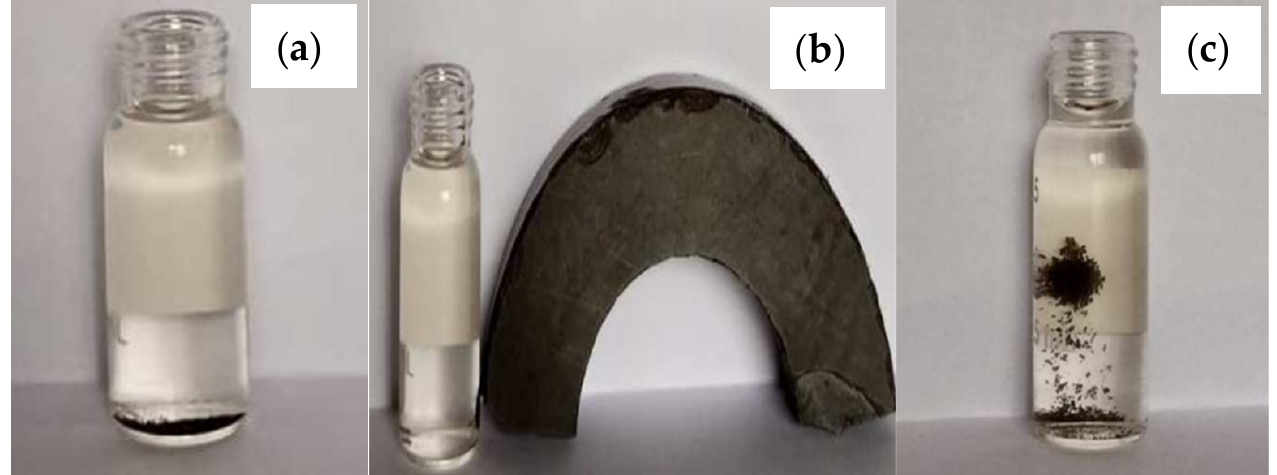
Figure 2. ( a ) nCDp/DT-Fe@MM without external magnetic field, ( b ) nCDp/DT-Fe@MM particles at- tracted to an external magnetic field, ( c ) nCDp/DT-Fe@MM particles in solution carried by an exter- nal magnetic field placed behind it.